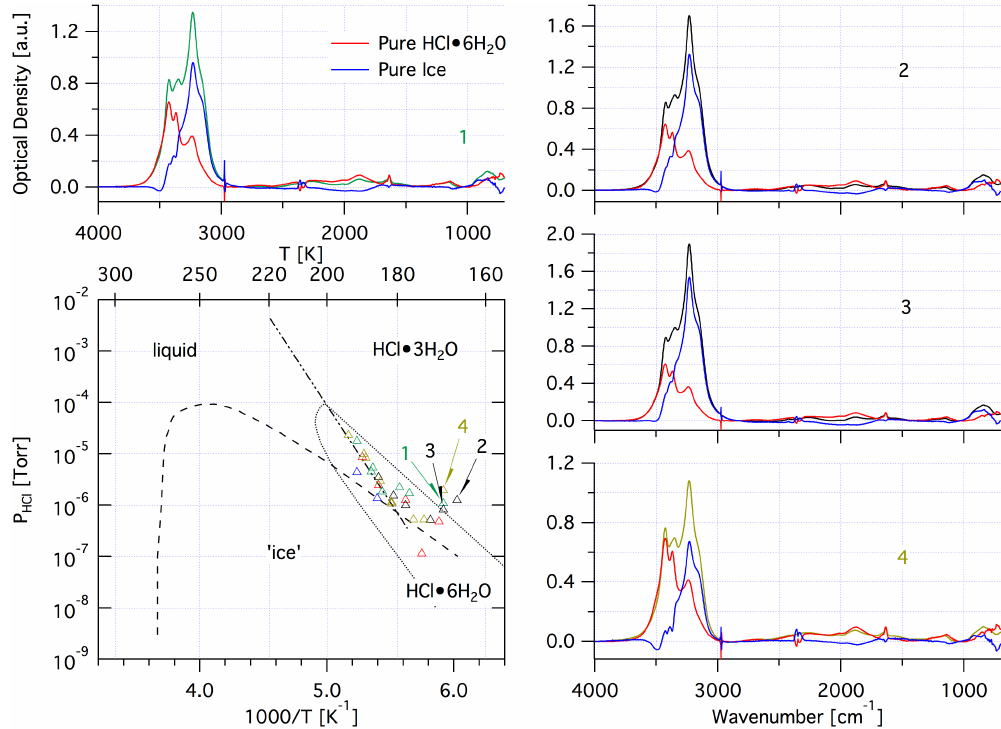
Figure 7. Selected measured FTIR spectra with their deconvolution into pure ice (blue) and pure HH (red) component. The measured FTIR Figure 7: Selected measured FTIR spectra with their deconvolution into pure ice 1232 absorption spectra are coloured according to where they fit into the binary HCl/H 2 O phase diagram. (blue) and pure HH (red) component. The measured FTIR absorption spectra are 1233 Table 2. Fit parameters for H 2 O and HCl interaction with internal stainless steel surfaces (SS304) of the coloured according to where they fit into the binary HCl/H